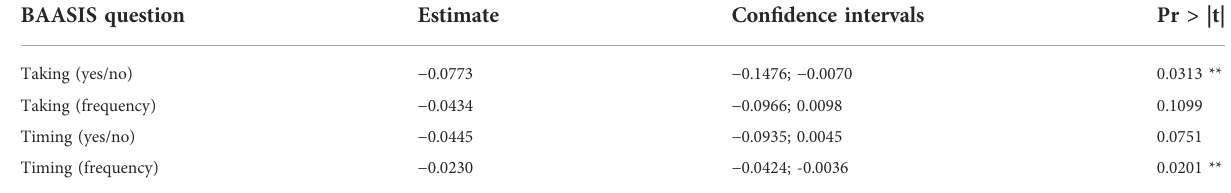
TABLE 2 Modeling of blood tacrolimus by the BAASIS © , corrected for dosing ( N = 243)*. BAASIS question